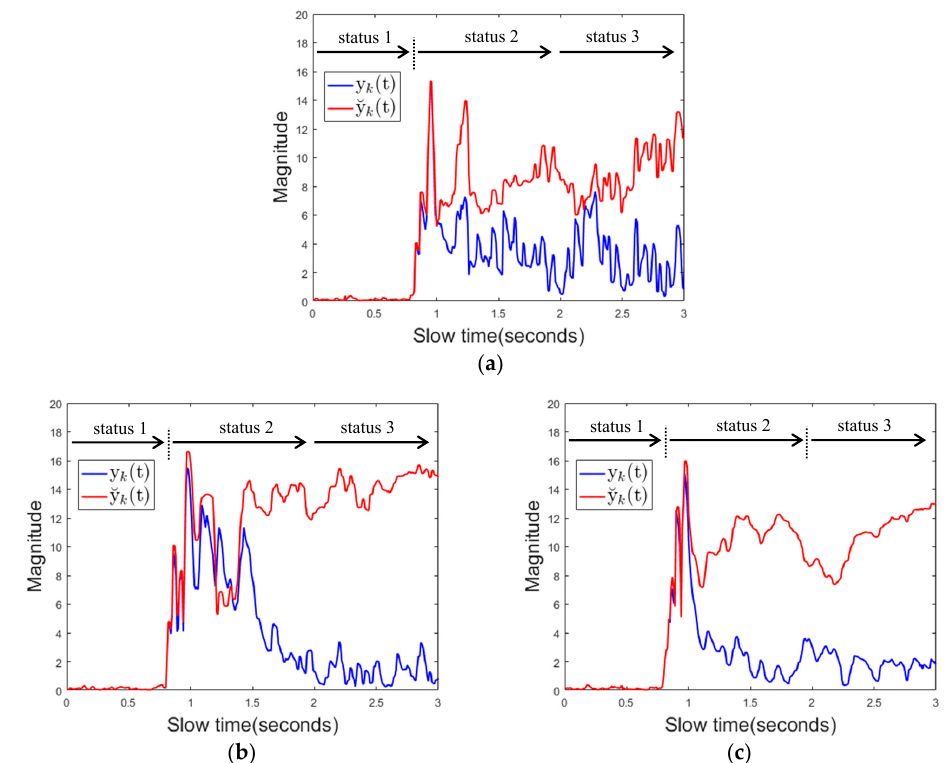
Figure 19. The maximum value of the received signal over slow time when using a mobile phone ( a ) texting ( b ) scrolling, touching ( c ) viewing.